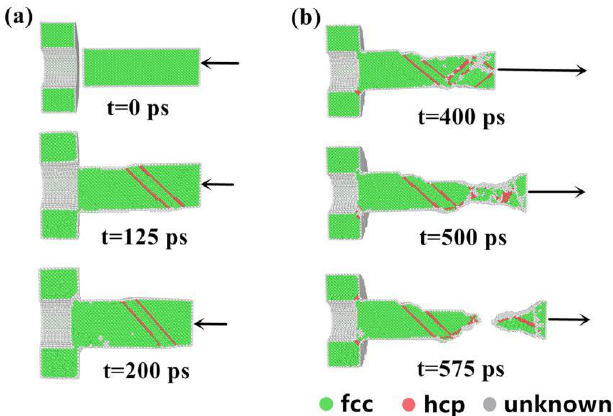
Figure 2. Structural evolution of Cu-Cu through common neighbor analysis (CNA) assembly for various times: ( a ) 0, 125 and 200 ps; ( b ) 400, 500 and 575 ps.